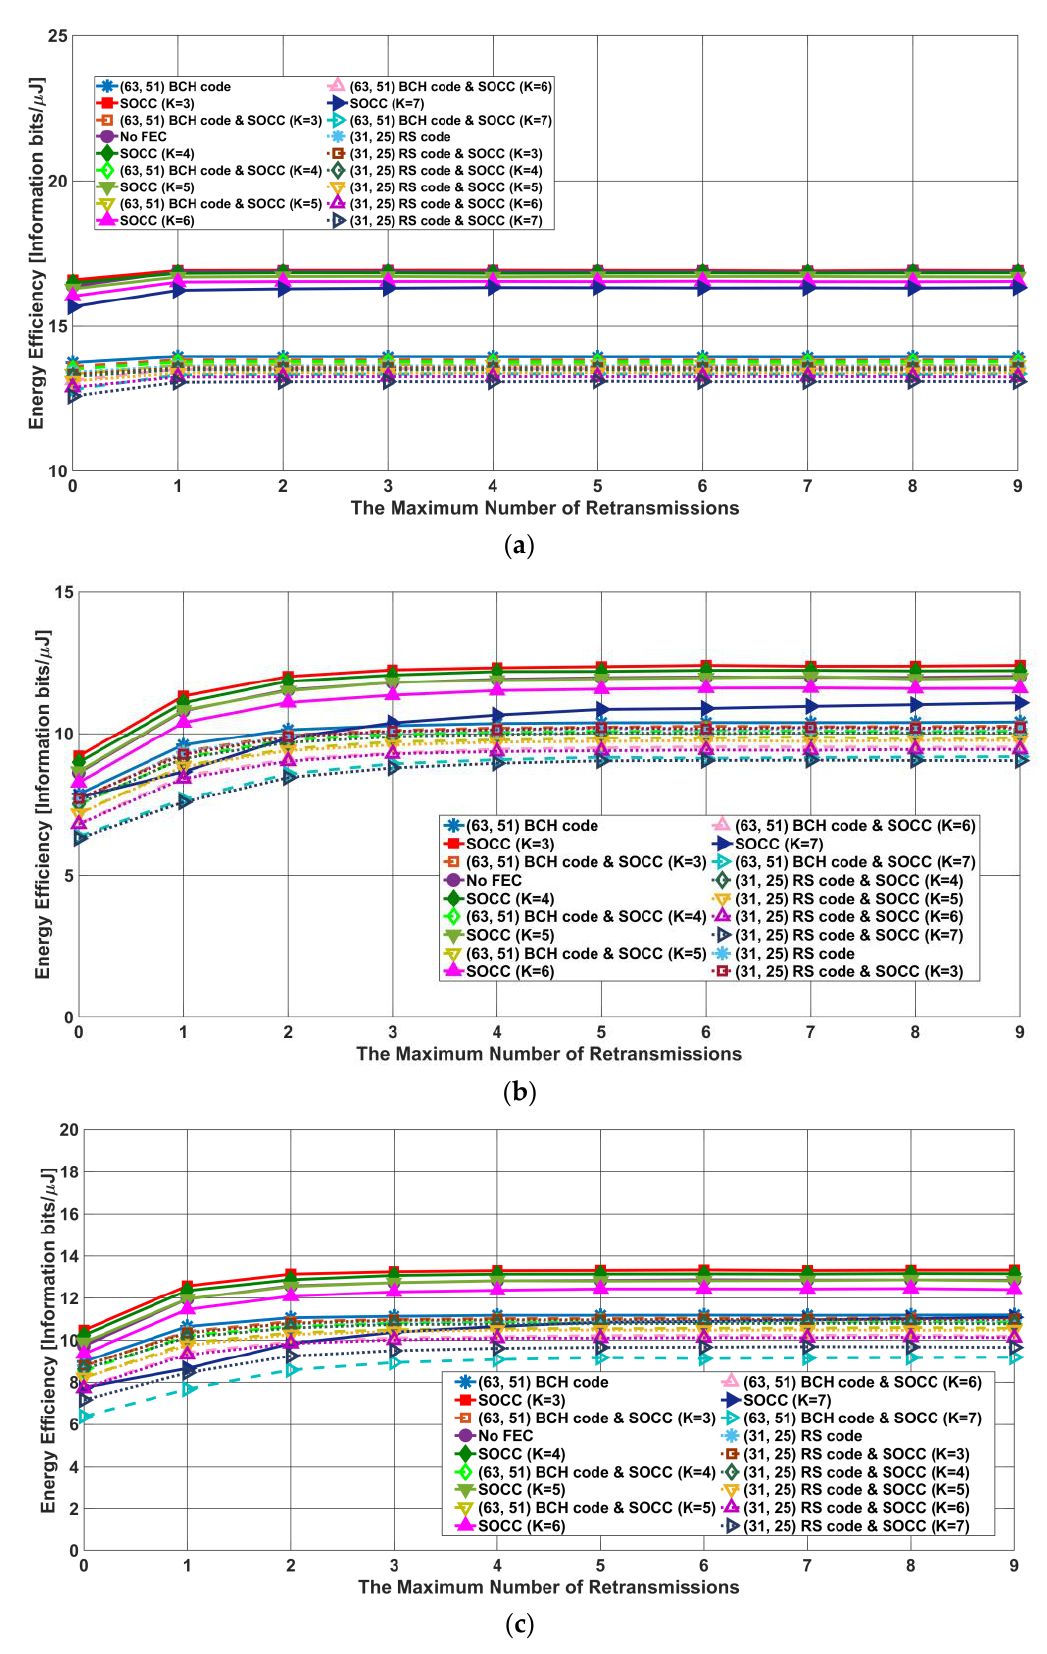
Figure 11. Energy efficiency as a function of the maximum number of retransmissions in the case of the burst pulse option with 𝑁 𝑐𝑝𝑏 𝑅 𝑆𝑂𝐶𝐶−1 = 32 for each link type: ( a ) LD, ( b ) MD, and ( c ) HD.